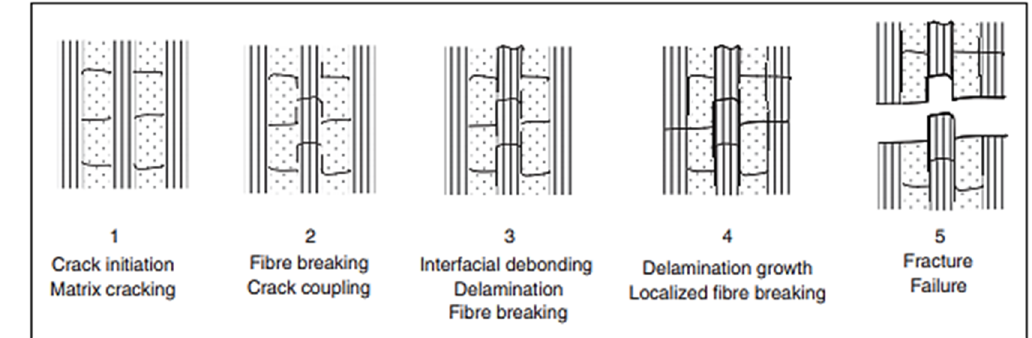
Figure 11. Damage formation in cross-ply laminate during tension–tension fatigue.